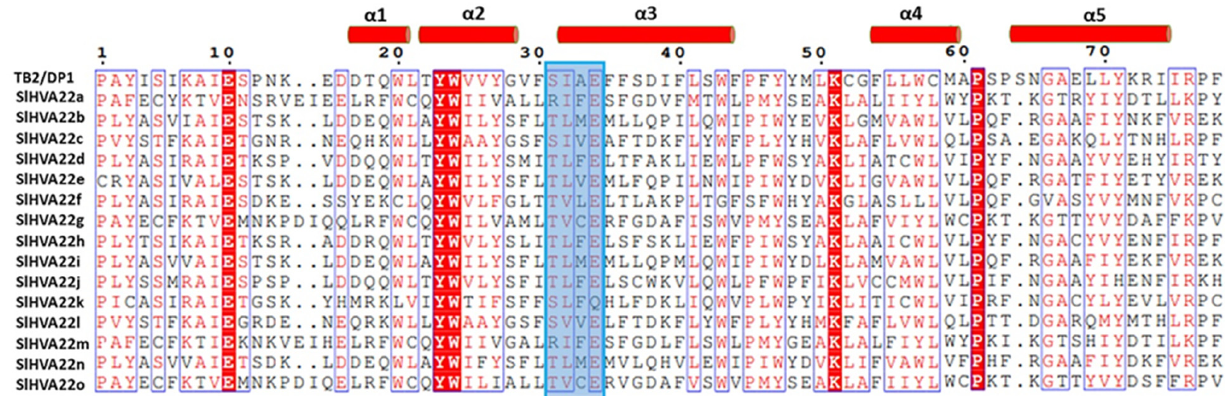
Figure 3. Alignment of TB2/DP1/HVA22 domains of SlHVA22 proteins with that of the typical human TB2/DP1. The secondary structural elements determined by the ESPript 3.0 web tool are indicated above the alignment. The putative conserved casein kinase II sites in the α -helix of the TB2/DP1/HVA22 domain are marked by a blue box.